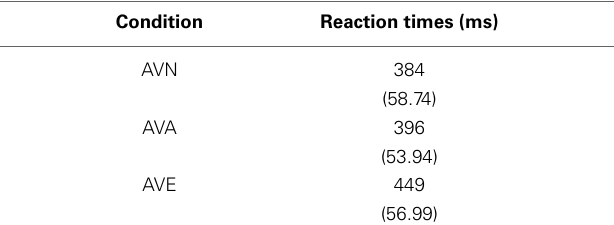
Table 3 | Means and standard deviations (in parentheses) of reaction times (ms) for “emotional” bimodal-AVE, “animal” bimodal-AVA and “neutral” bimodal task-AVN, independently of the